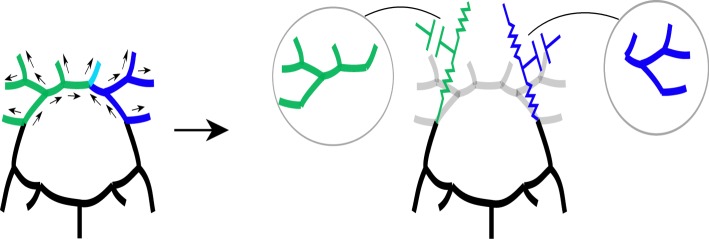
Arrows indicate the direction (not magnitude) of Q¯, and also which arteries are lumped into WK3 models for two selected sites of truncation: the left and right internal carotid arteries.